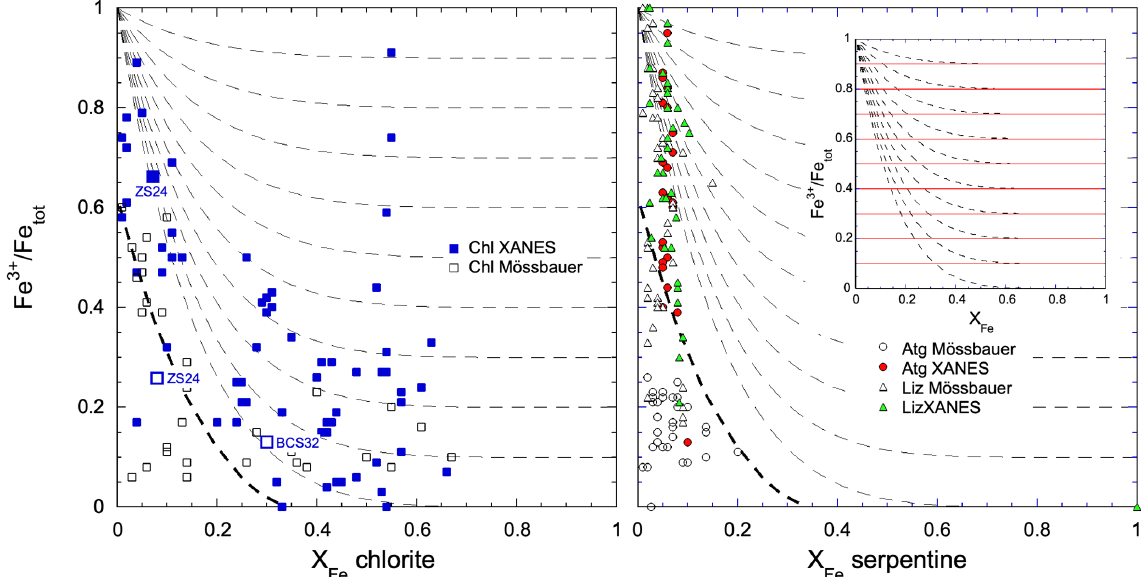
Figure 4. Fe 3 + / Fe total ratios from Mössbauer (open symbols) and XANES (filled symbols) measurements in chlorites (Chl) and serpentines (Atg: antigorite; Liz: lizardite) are reported as a function of X Fe . Inset shows iso-values of the Fe 3 + / Fe total ratio in red, and the dashed curves show the corresponding Fe 3 + / Fe total ratio after photo-oxidation of isolated Fe 2 + at low X Fe (see text). Dashed curves after photo- oxidation are shown in all diagrams for comparison with XANES analyses. Photo-oxidation accounts semi-quantitatively for the higher Fe 3 + / Fe total ratio obtained by XANES on the Mg-rich side of the diagram. The thick dashed curve parallel to model curves is adjusted to the lowest XANES data on chlorites and reported at the same place on the serpentine diagram. It defines a field of low Fe 3 + / Fe total ratios where almost no XANES data on low-Fe chlorites and antigorites plot due to photo-oxidation, while Mössbauer data cover a large portion of